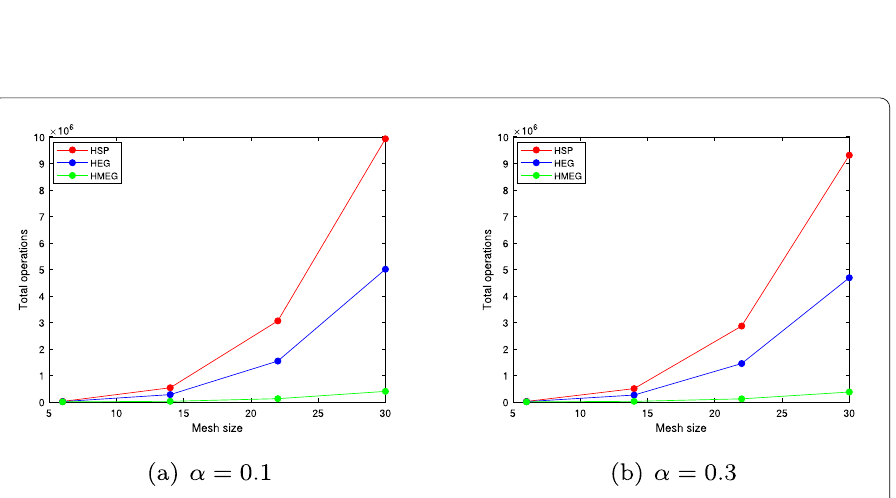
Figure 5 The total arithmetic operations plot of the HSP, HEG and HMEG methods for Example